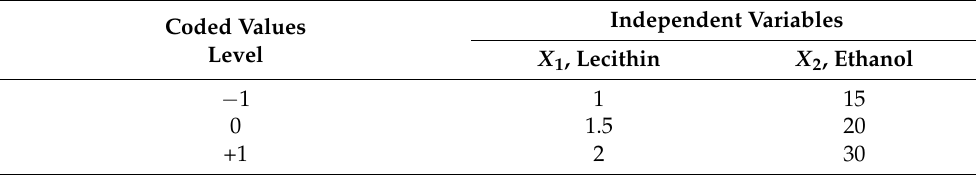
Table 1. Selection of independent variables.